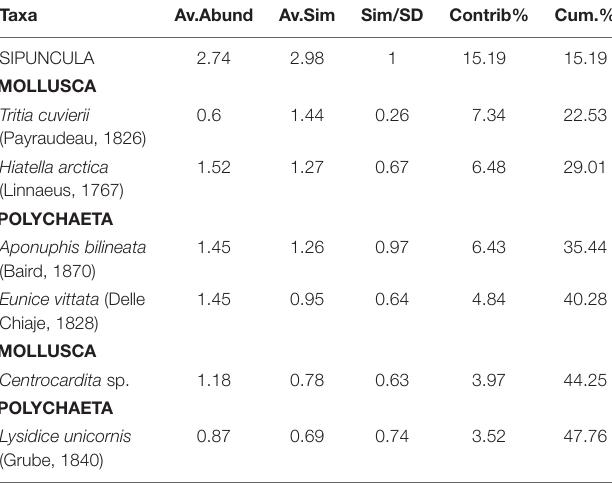
TABLE 7 | Results of similarity of percentages test, showing taxa that mostly contributed to similarity among